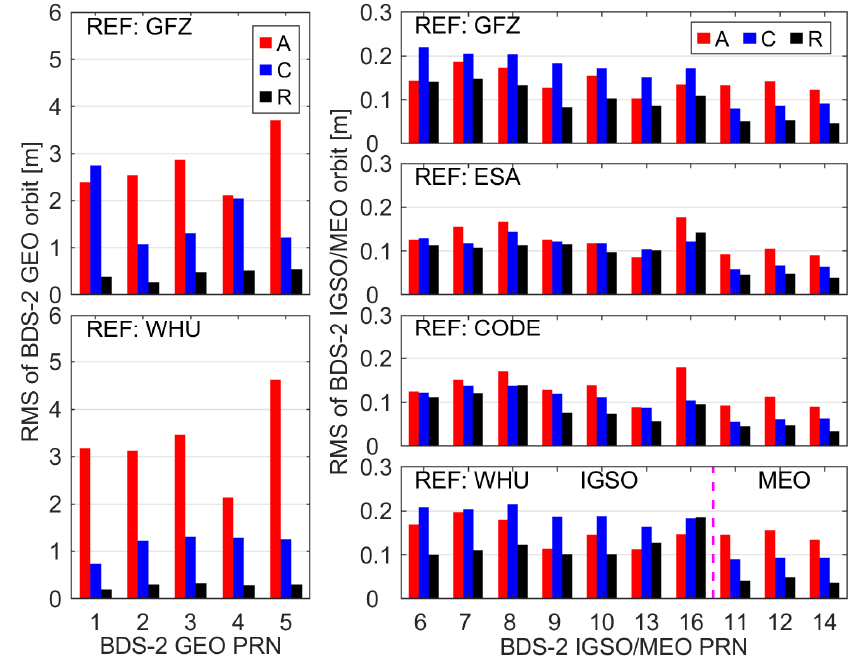
Figure 9. RMS of BDS-2 ISU orbits based on B1I/B3I compared with different MGEX ACs in the along-track (A), cross-track (C), and radial (R) directions, respectively. Figure 10 shows the RMSs of ISU orbits based on B1I/B3I and B1C/B2a in along-track, cross-track, and radial directions for SECM MEO, CAST MEO, and CAST IGSO satellites, where the gray dashed line indicates that the accuracy of ISU B1I/B3I-based and B1C/B2a- based are the same. We can find that the consistency of ISU B1C/B2a-based orbit products for BDS-3 MEO satellites is worse than B1I/B3I-based. For the radial directions of BDS-3 IGSO satellites, we can see that the consistency of B1I/B3I-based and B1C/B2a-based for different MGEX ACs are different, and the GFZ shows the best consistency with ISU. Figure 11 shows the box plot of RMSs of ISU orbits based on B1I/B3I and B1C/B2a IGSO satellites. The five short horizontal lines from the top to the bottom of the box chart represent the 100%, 75%, 50%, 25%, and 0% quantiles, respectively. It can be seen that the median values of RMSs of the along-track based on B1I/B3I for SECM MEO, CAST MEO, and CAST IGSO satellites are approximately 0.061 m, 0.056 m, and 0.146 m, respectively.